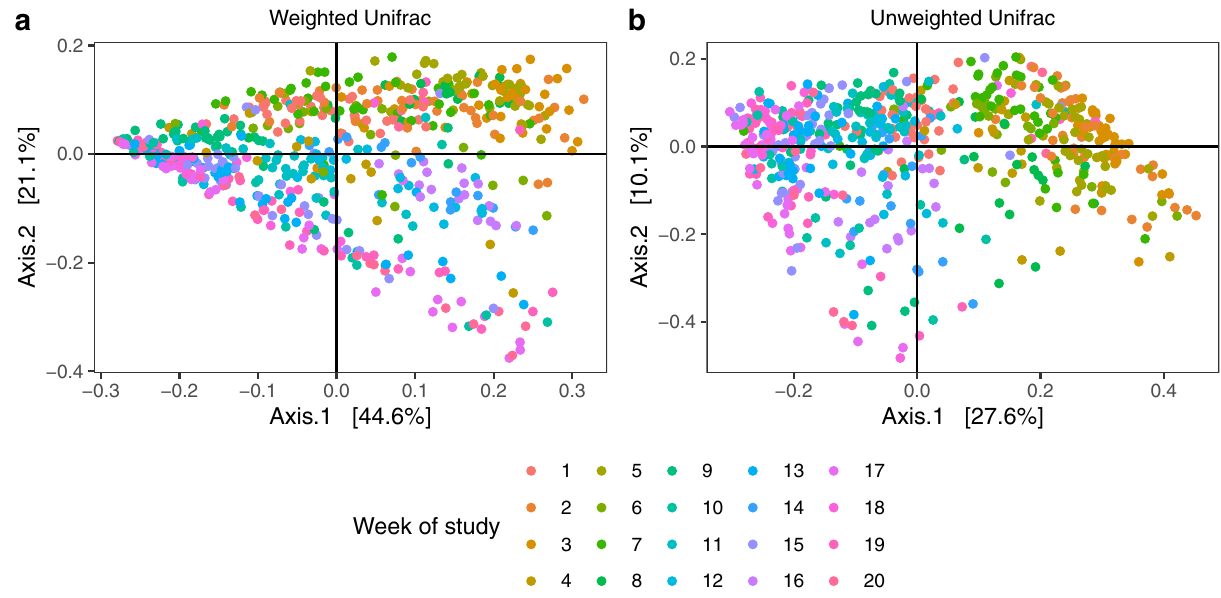
Figure 2. Temporal changes in interdigital skin microbial community composition. Principal coordinate analysis (PCoA) plot of ( a ) weighted and ( b ) unweighted Unifrac dissimilarities between microbial communities at the operational taxonomic unit (OTU) level. Each dot represents a sample coloured by week of study. Number of samples (n) =